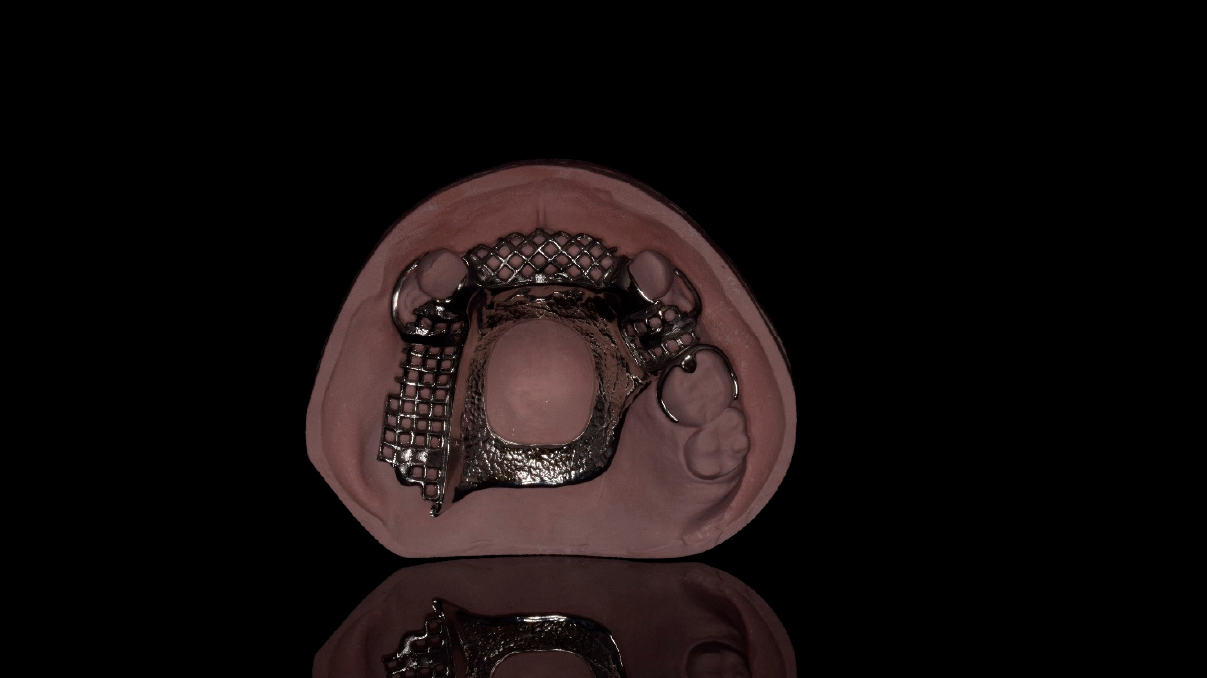
Figure 1. Traditional cast cobalt chromium framework with conventional infrabulge and cast circumferential clasps. Display of such clasps may be deemed unesthetic by patients.